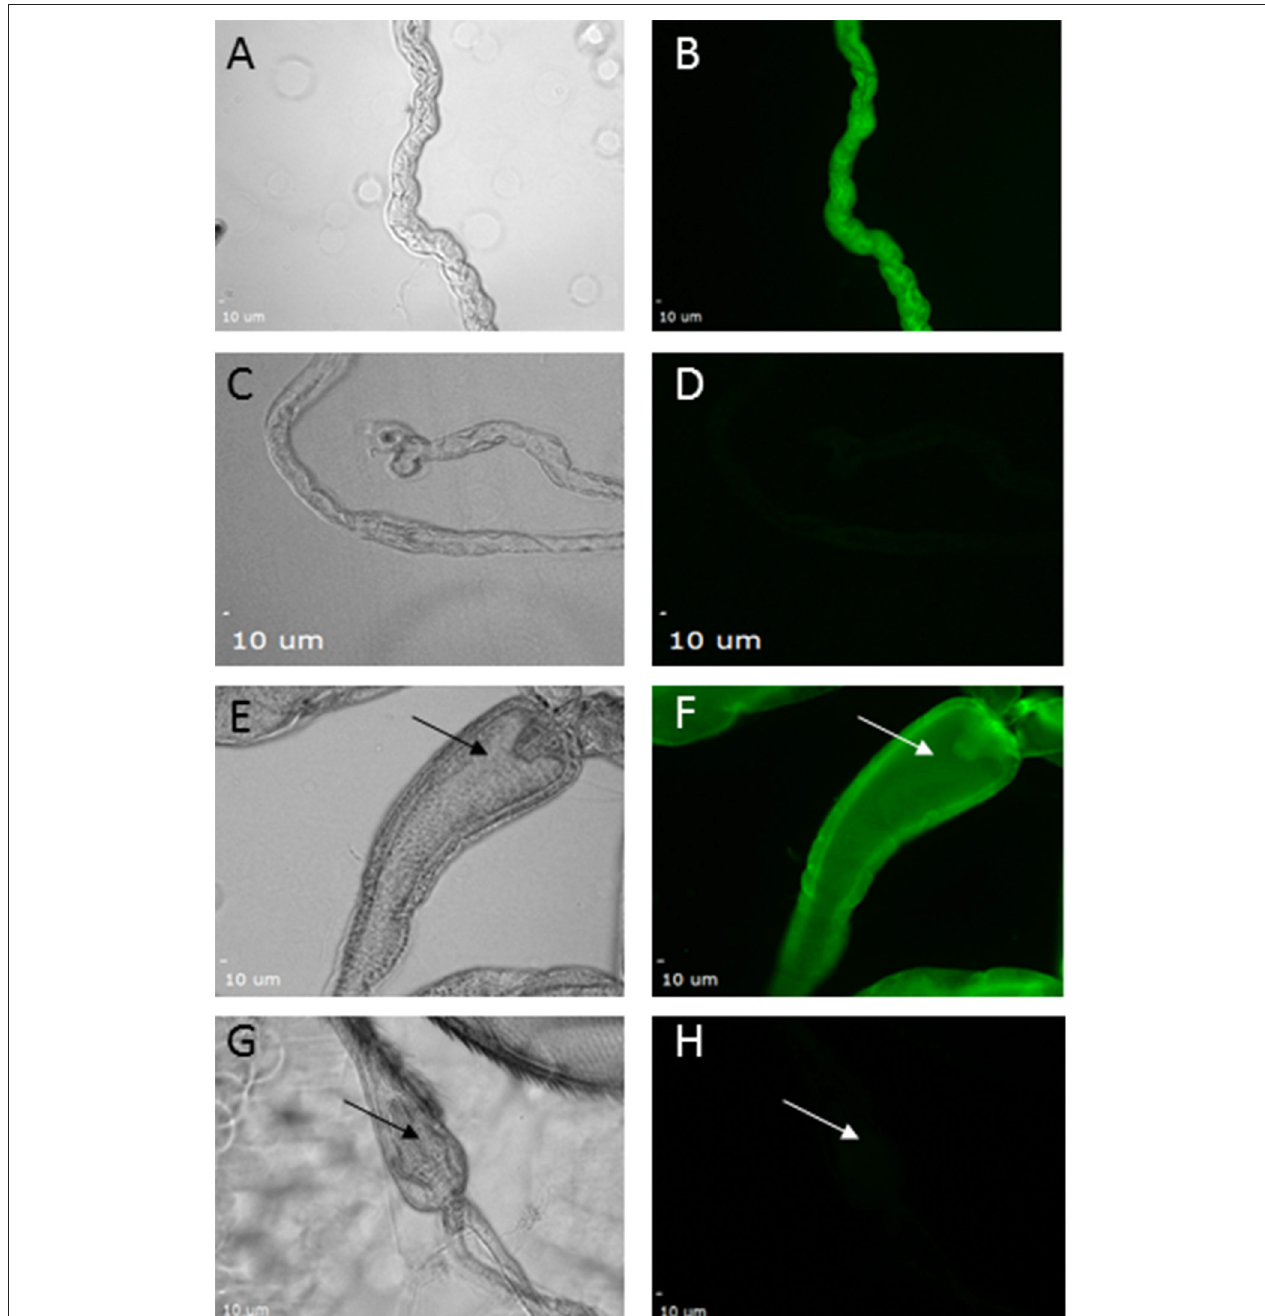
FIGURE 8 | Expression of pdgy was detected in the gut and Malpighian tubules using an enhancer trap line. GFP expression was detected in the Malpighian tubules (A–D) and in the gut (E–H) . Bright field images show Malpighian tubules (A,C) . Fluorescence expression was detected in (B) when the secondary antibody was excited by wavelengths in the green wavelengths as opposed to a control (D) with a secondary antibody not excited or emitting in this same wavelength. GFP expression was also expressed in the gut. Shown here is the recognizable portion of the gut, the cardia. Expression was seen in (F) but not in (H) with the same conditions as above. Bright field images showing the field (E,G) . Arrows point to the cardia in each image.